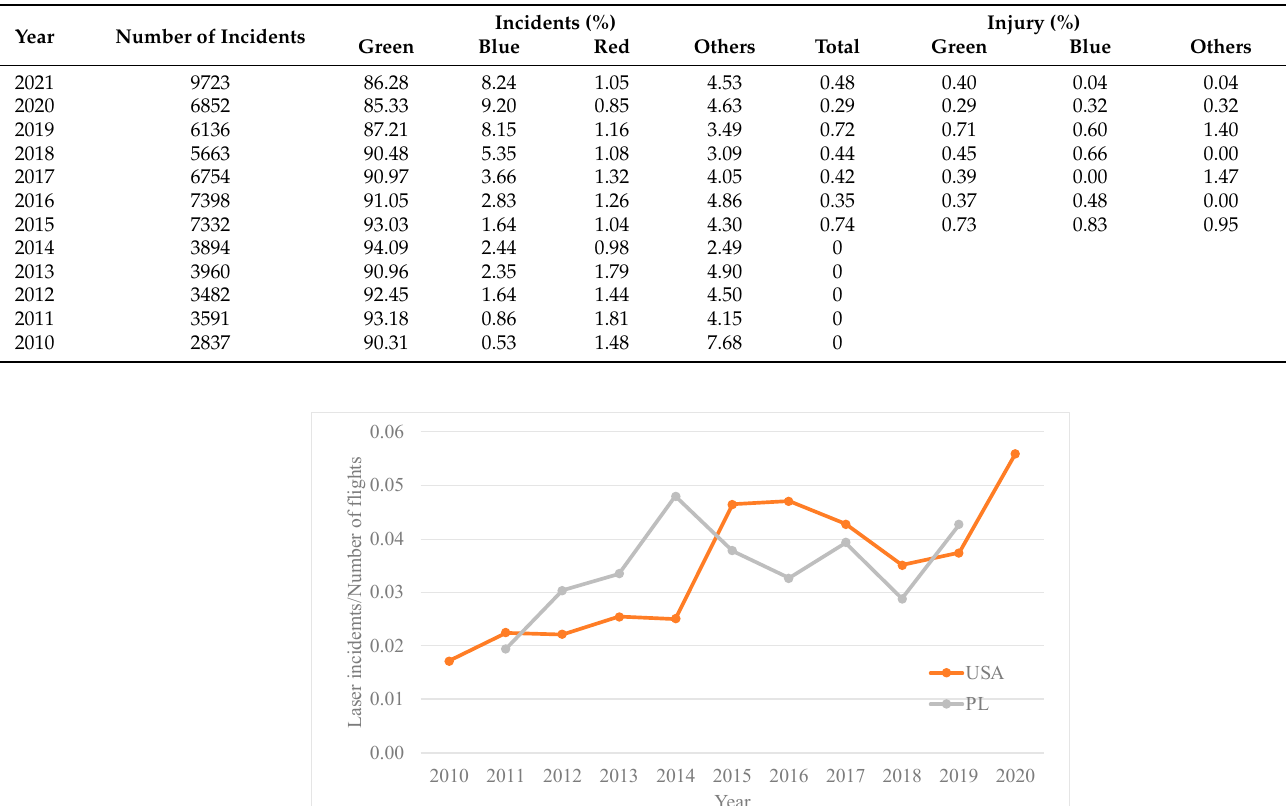
Table 1. Number of incidents, percentage of incidents for lasers of different wavelengths, and percentage of injuries caused by lasers of different wavelengths. Own elaboration based on data from [28].